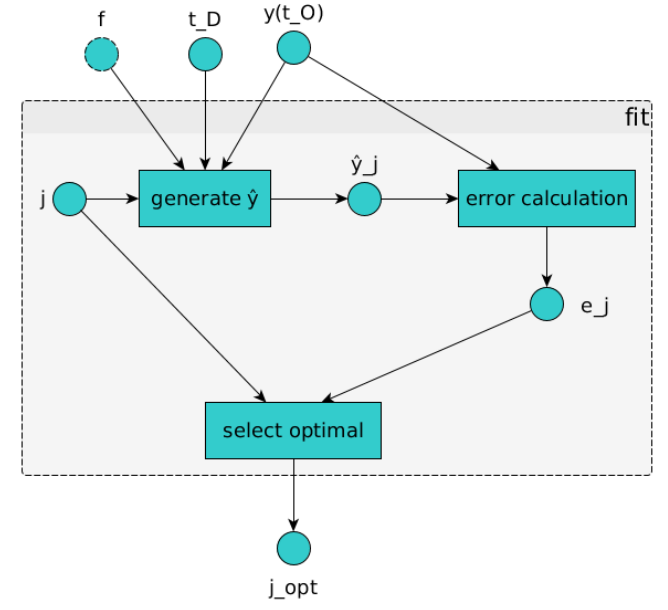
Figure 2. Fitting method diagram. First, ˆ y j resampled time series are generated from each joining method ( j ∈ J ). Using the generated resampled time series, error is calculated in each case and the optimal solution is selected j opt